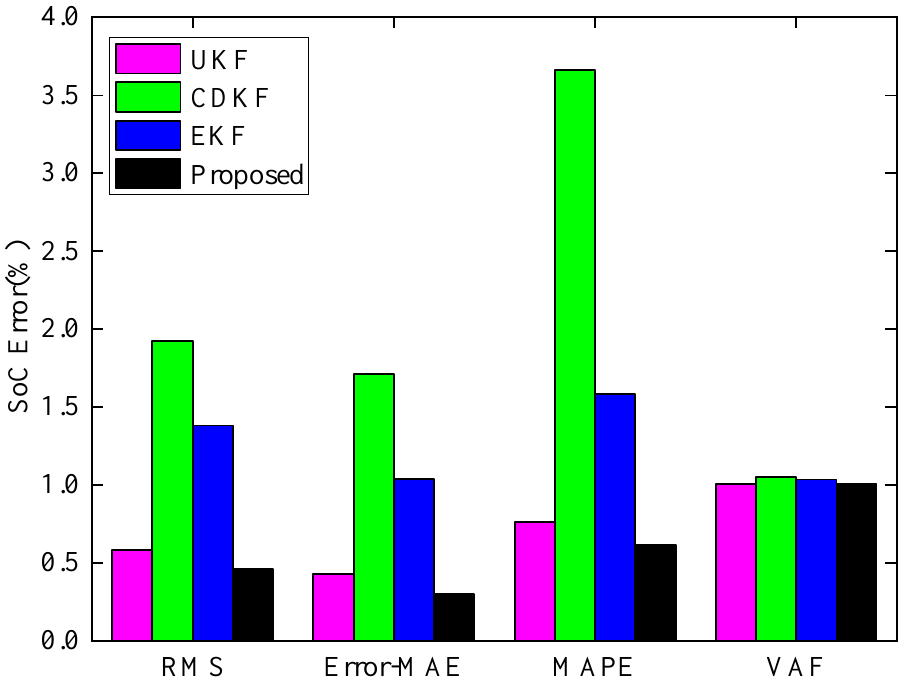
Figure 15. The four evaluation indexes of the initial SoC guess were 0.7 under the US06 condition.